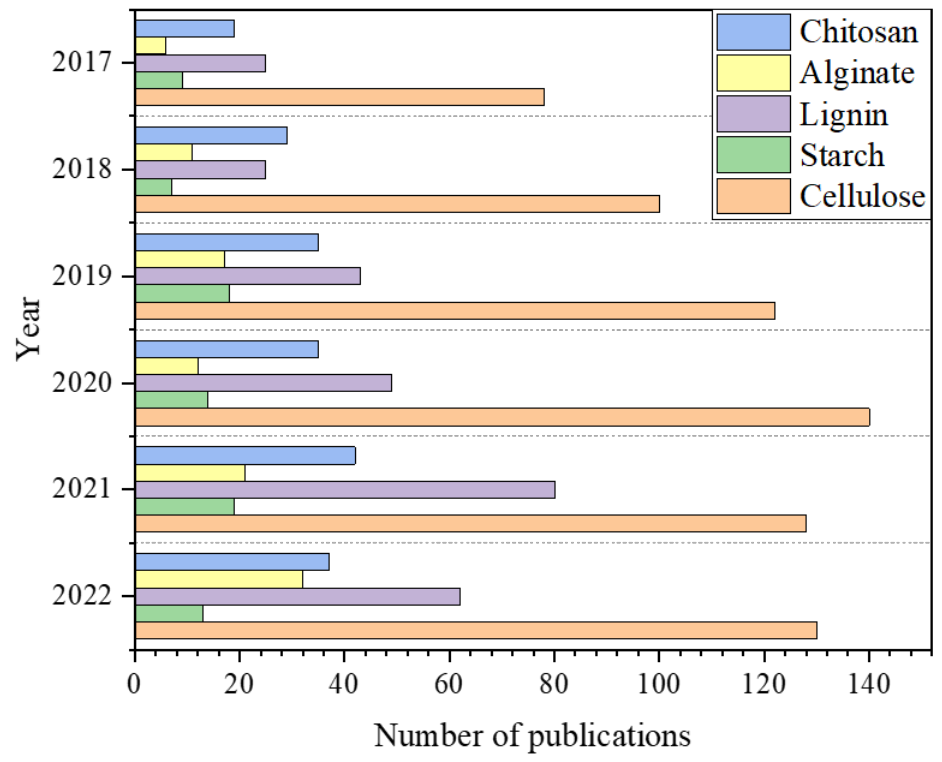
Figure 1. Graphical representation of the published research articles on five (5) different kinds of green biopolymers between 2017–2022 (using Scopus database; date of search 16 September 2022).